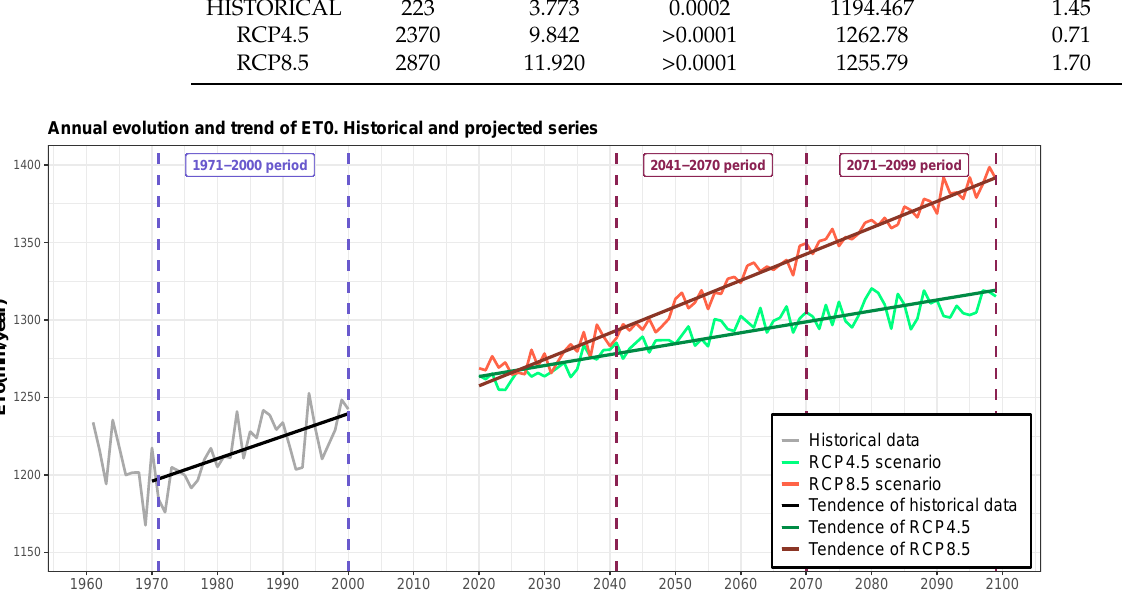
Figure 6. Evolution of the observed ET 0 in the historical series and in the two climate change scenarios considered. The linear trend models have been obtained using the Theil–Sen estimator and their significance was calculated using the Mann–Kendal